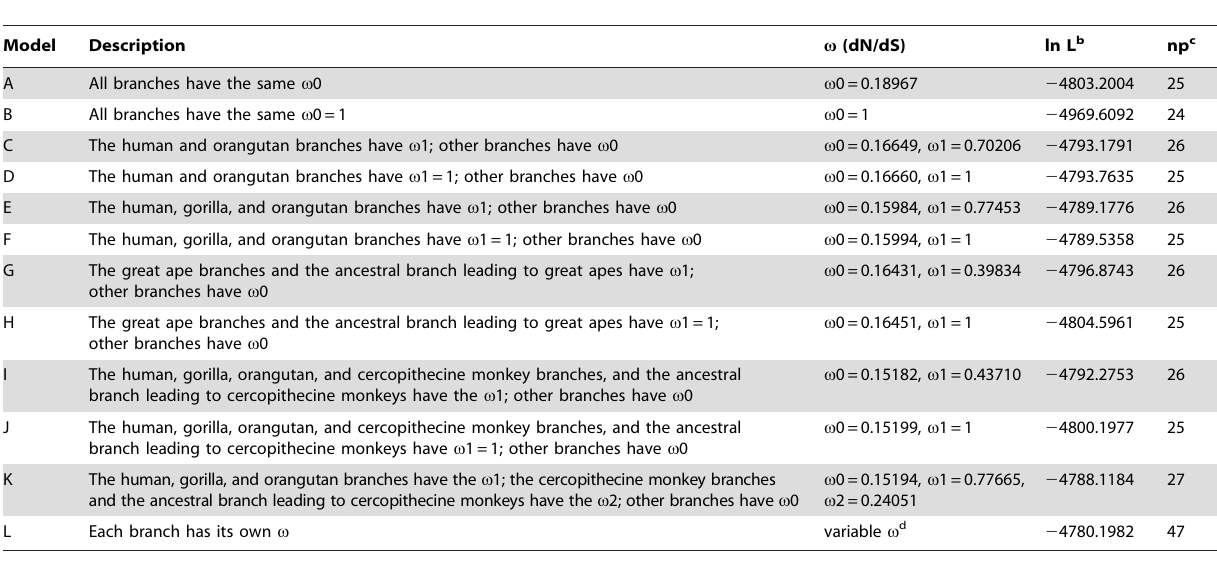
Table 2. Models and parameter estimates for likelihood ratio tests of selective pressure on catarrhine MOXD2 gene a .